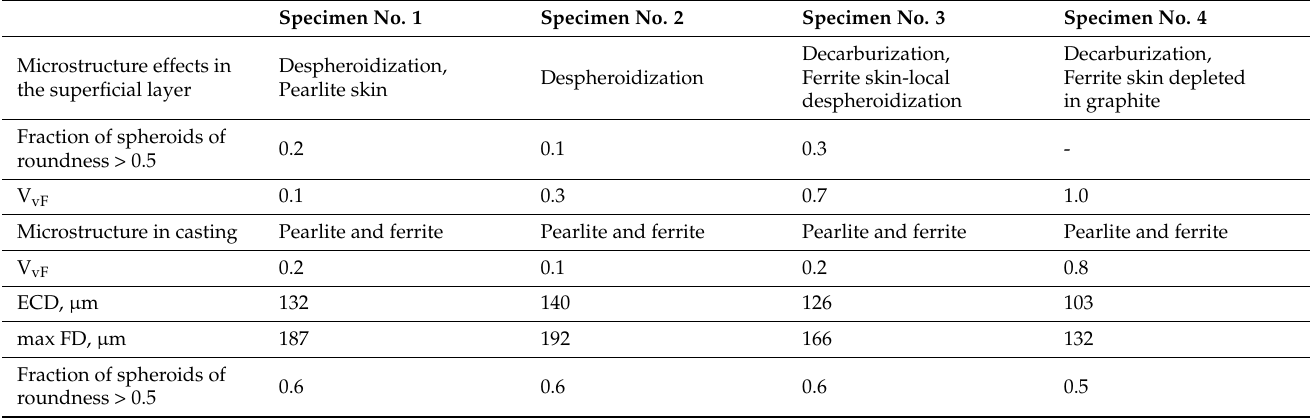
Table 2. Morphological characteristics of the microstructure in the experimental